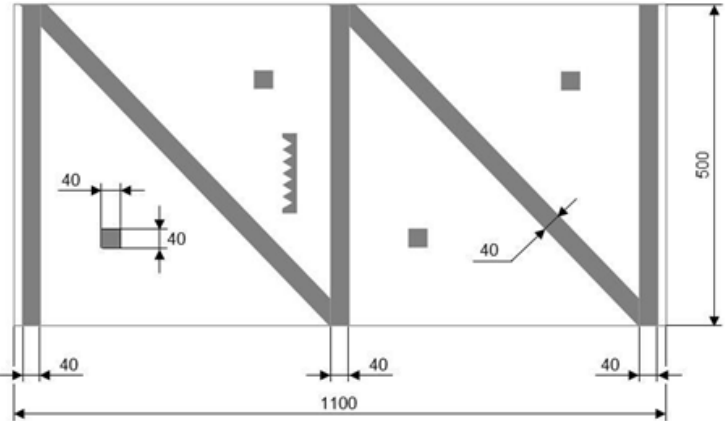
Figure 7. Shape and dimension of reference specimen (mm).